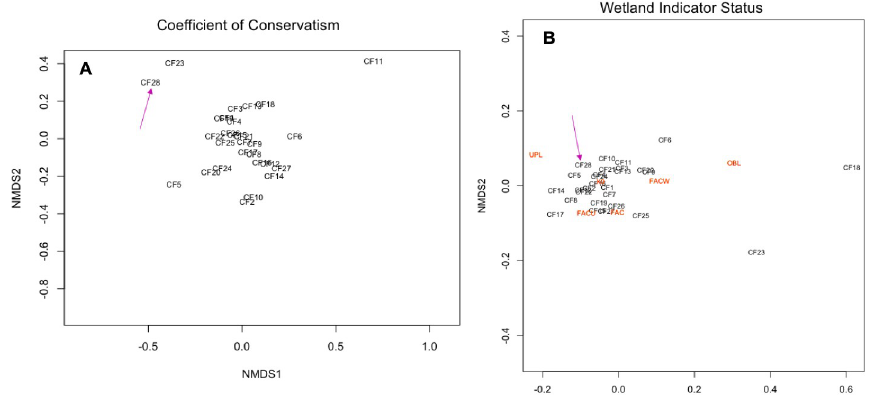
Fig 6. Nonmetric multidimensional scaling (NMDS) of (A) Coefficients of Conservatism (ranges from 0 to 10 [36]) frequency values, and (B) wetland indicator status frequency of each comparison flora, where the orange font indicates each category: facultative (FAC), facultative upland (FACU), facultative wetland (FACW), obligate wetland (OBL), and upland (UPL); NA indicates that wetland indicator status was not provided [36]). CF28 is pointed out with a pink arrow in each figure